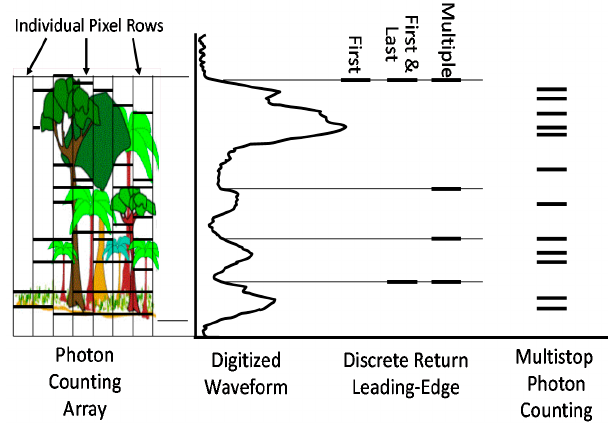
Figure 1. A comparison of Single Photon Lidars with conventional Discrete Return and Digitized Waveform lidars in interacting with a tree canopy (Courtesy of D. Harding, NASA GSFC).